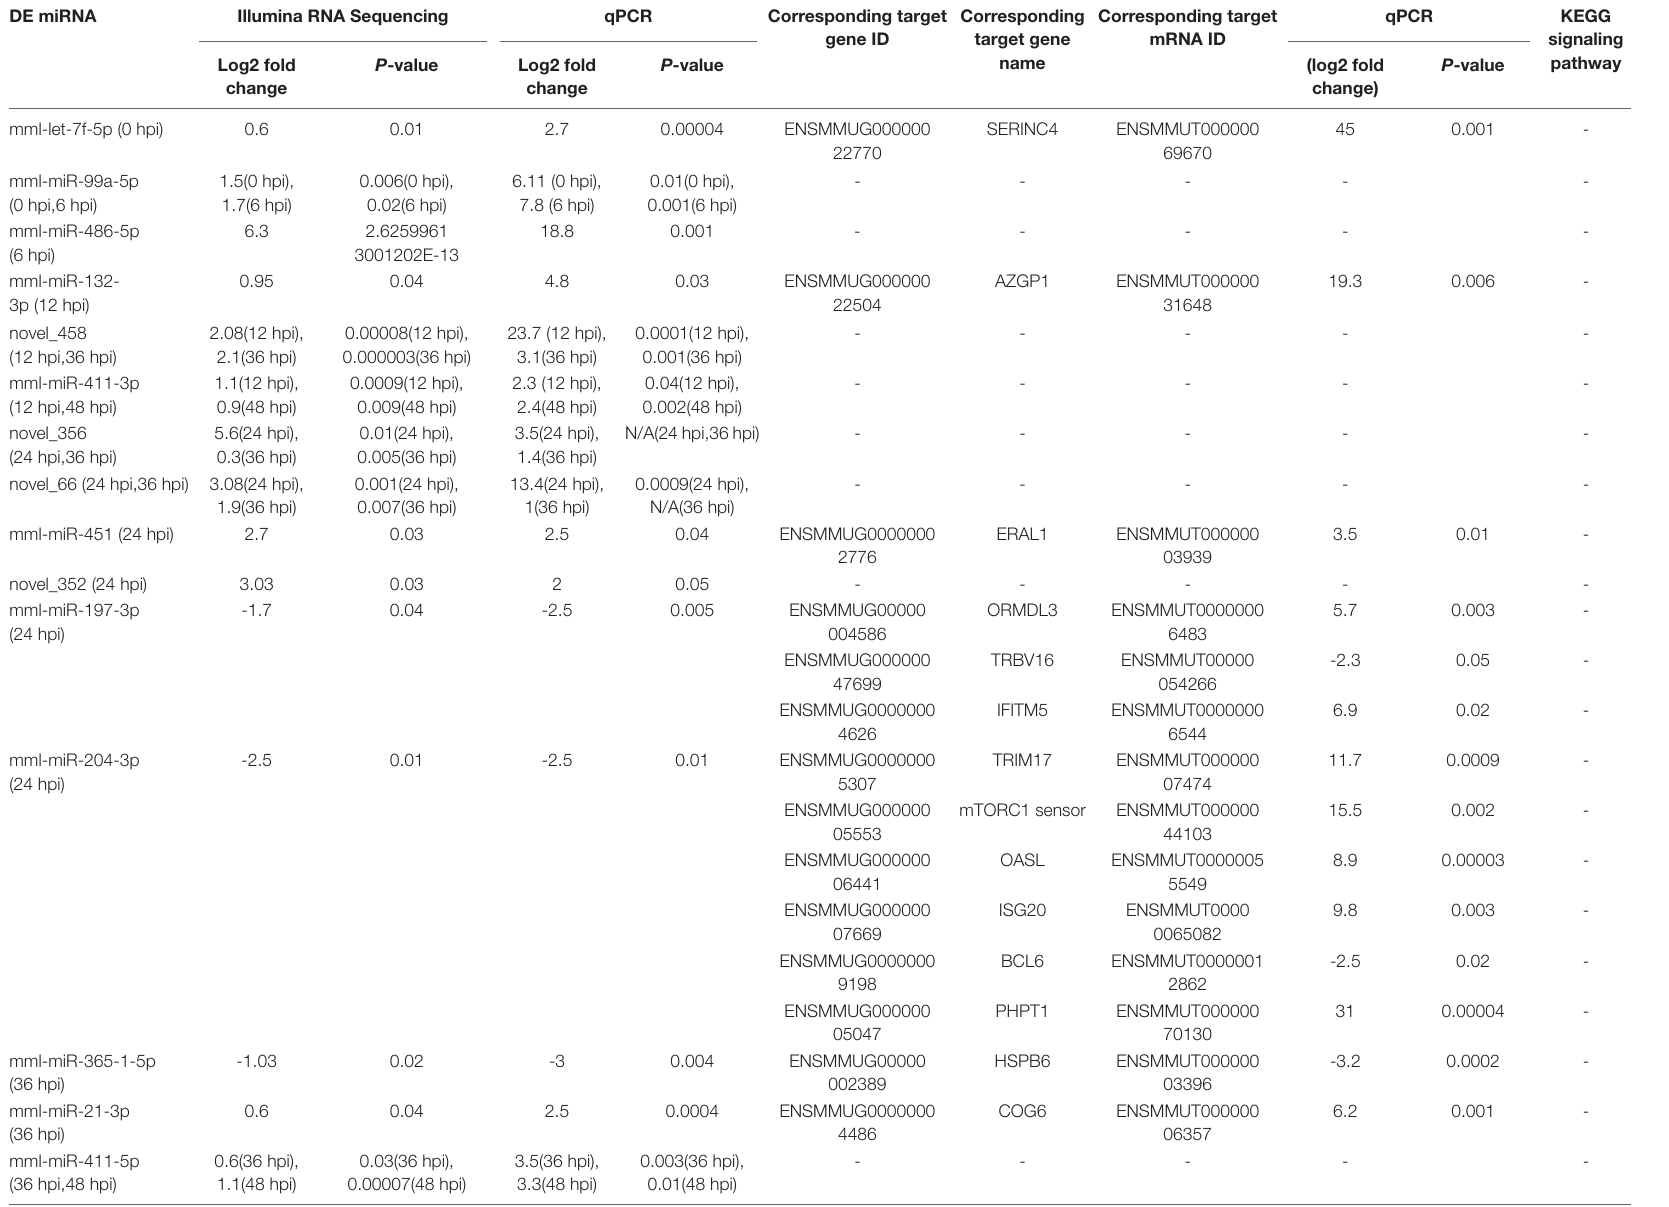
TABLE 1b | The other DE miRNAs without targets by bioinformatics or without significant targets by qPCR and not implicated in the signaling pathways, are marked by ( −